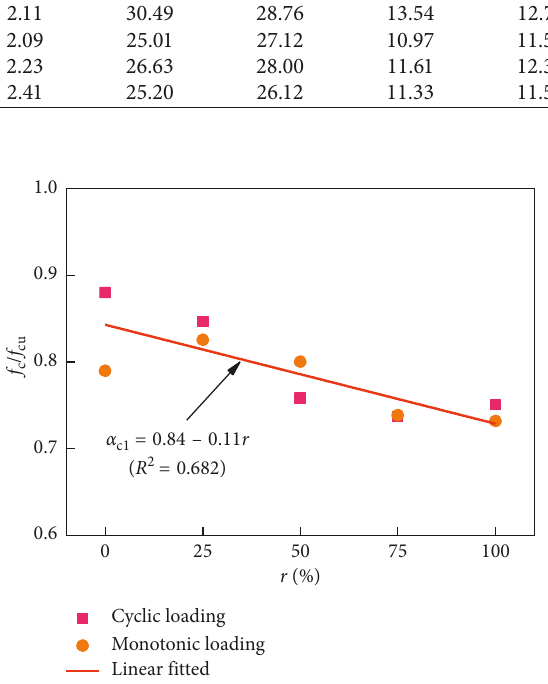
Figure 3: Compressive strength of the RAC. Figure 4: Relation between the prism compressive strength and cube compressive strength.